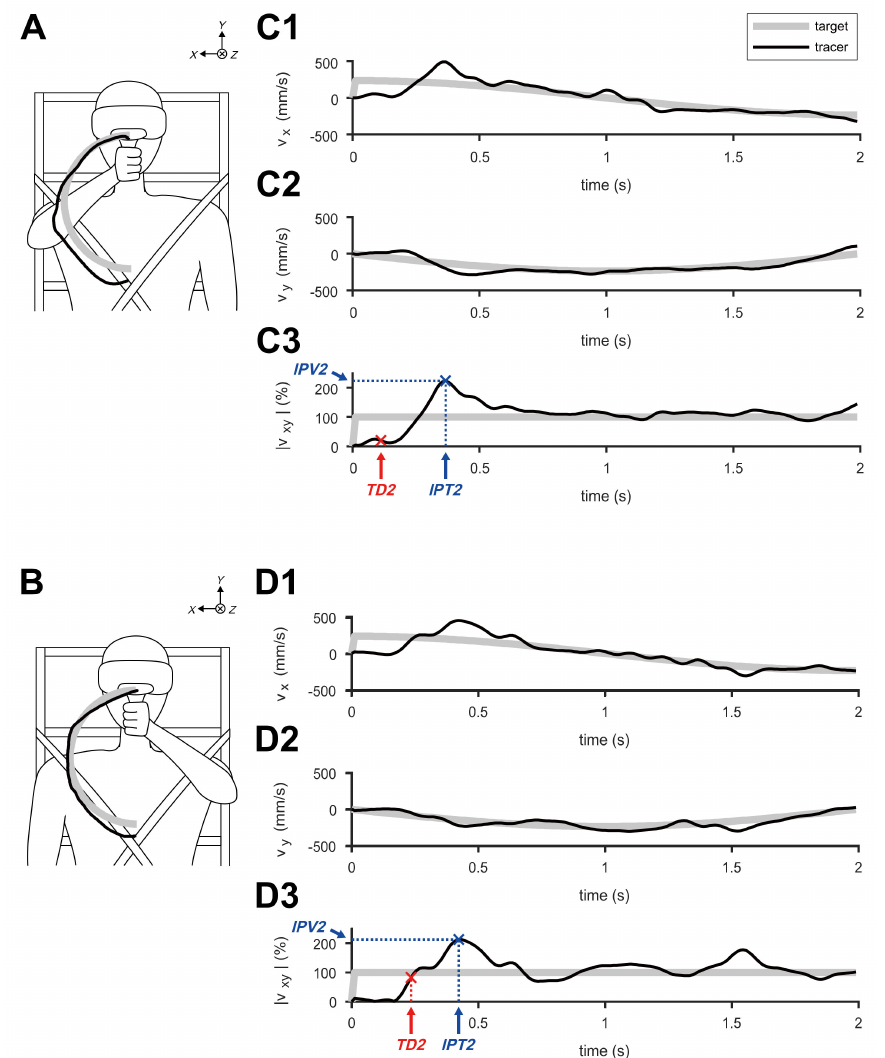
Figure 2. Typical examples of velocities during the first half-orbit of circular tracking movements at 0.500 π rad / s (S2). ( A ) Trajectories of the target and tracer performed by the dominant hand ( DH ) on the frontal plane. ( B ) Trajectories of the target and tracer performed by the non-dominant hand ( NDH ) on the frontal plane. (C1) Velocity of the DH calculated on the X -axis and (C2) on the Y -axis. (C3) Computed speeds on the frontal plane, normalized to S2 . (D1) Velocity of the NDH calculated on the X -axis and (D2) on the Y -axis. (D3) Computed speeds on the frontal plane, normalized to S2